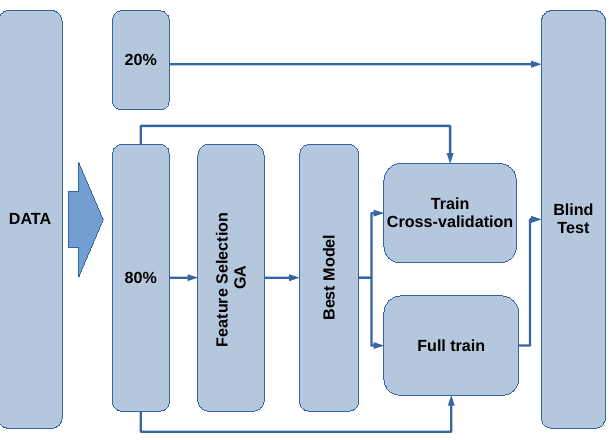
Figure 2. Flowchart of the proposed methodology for the model generation and